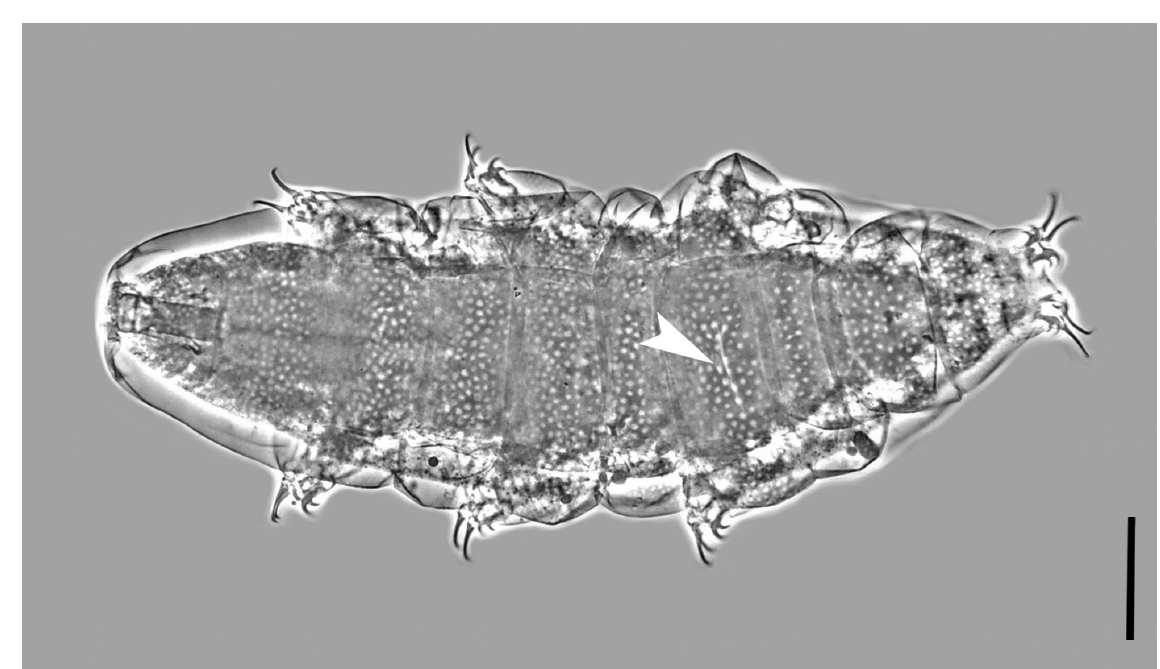
Fig. 3. Milnesium pelufforum sp. nov., paratype, young (slide No. 5898 (Pilato and Binda Collection)). Habitus. The arrowhead indicates the dorsal cuticular groove constantly present in young specimens at the level of legs III. Scale bar = 30 µm.